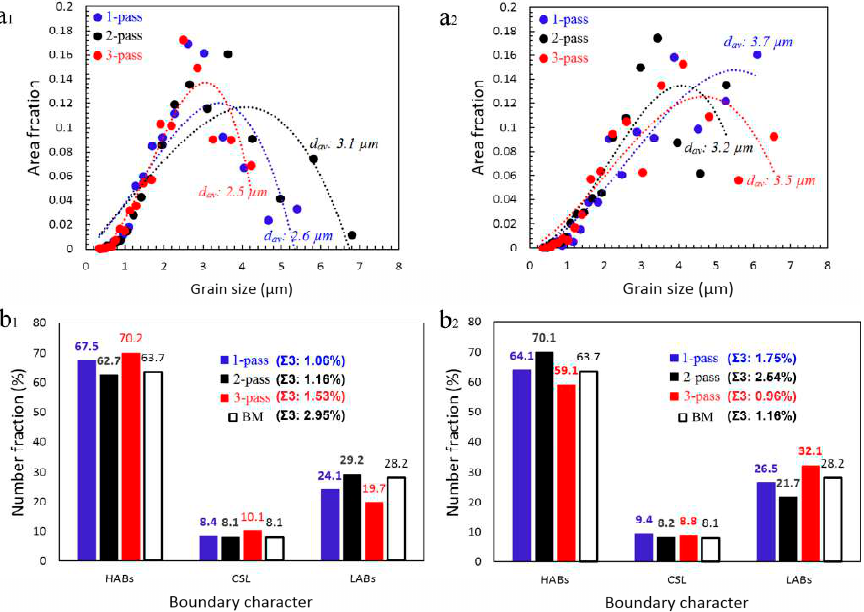
Figure 14. ( a ) Grain size and ( b ) grain boundary characterization distribution: ( a1 , b1 ) SZ-I and ( a2 , b2 ) SZ-II. ( a2 , b2 )